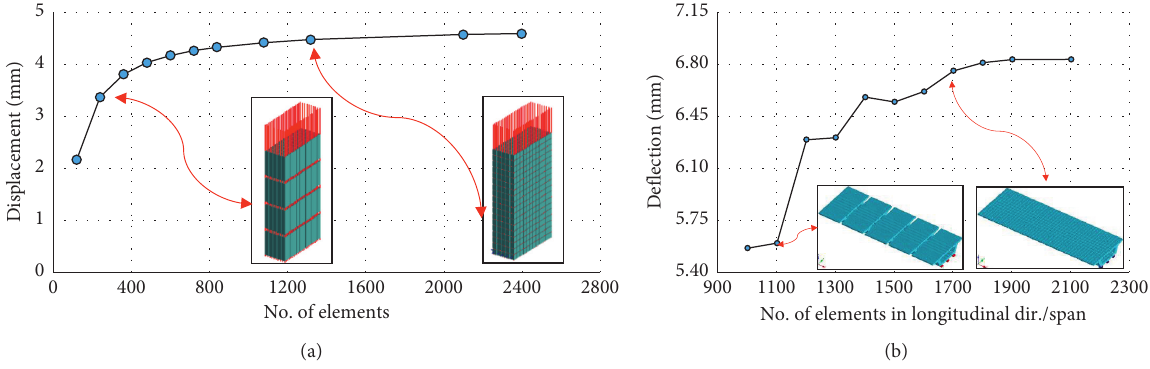
Figure 14: Mesh sensitivity of the column and the box girder. (a) Column. (b) Box girder.